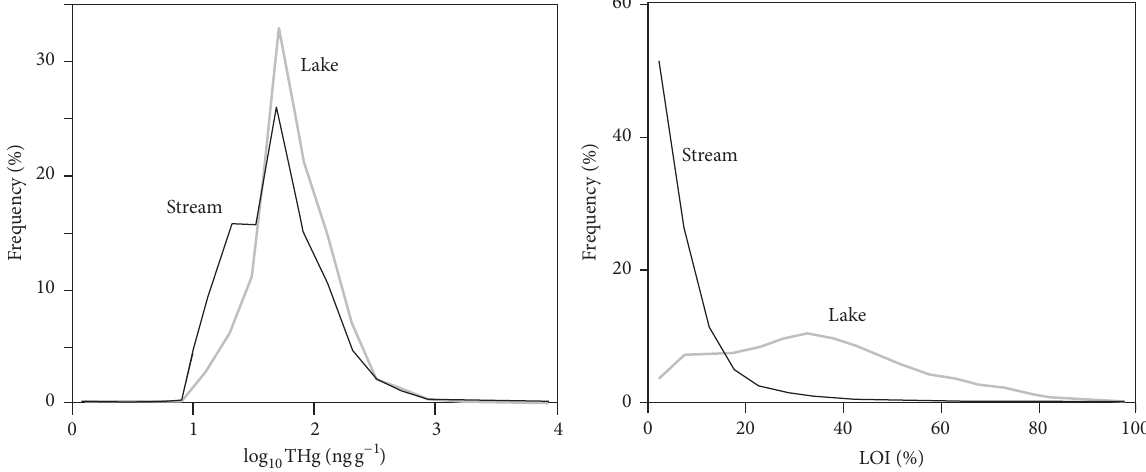
Figure 5: Frequency diagram for the compiled THg [log 10 (ng g −1 )] and LOI (%) data across